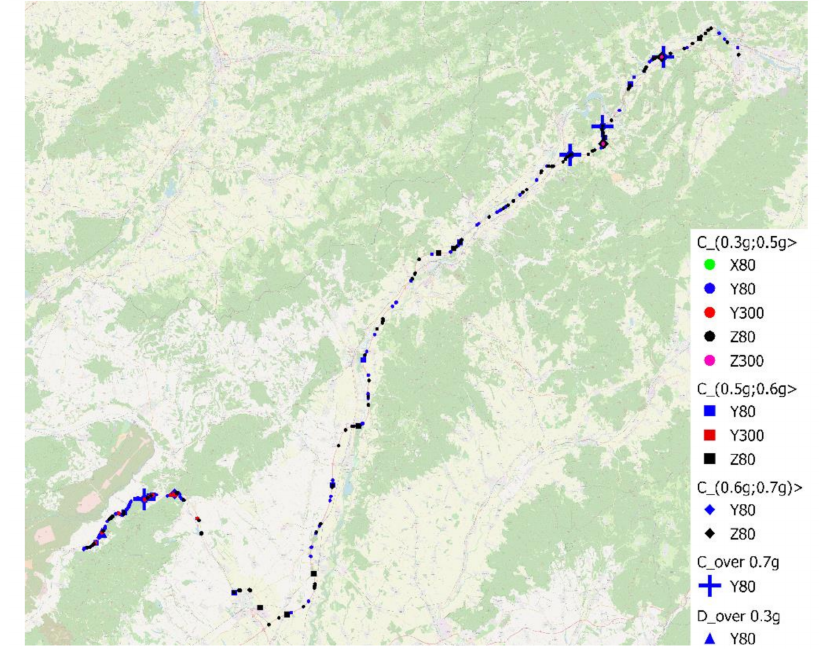
Figure 16. Exceptional events during transport (map by